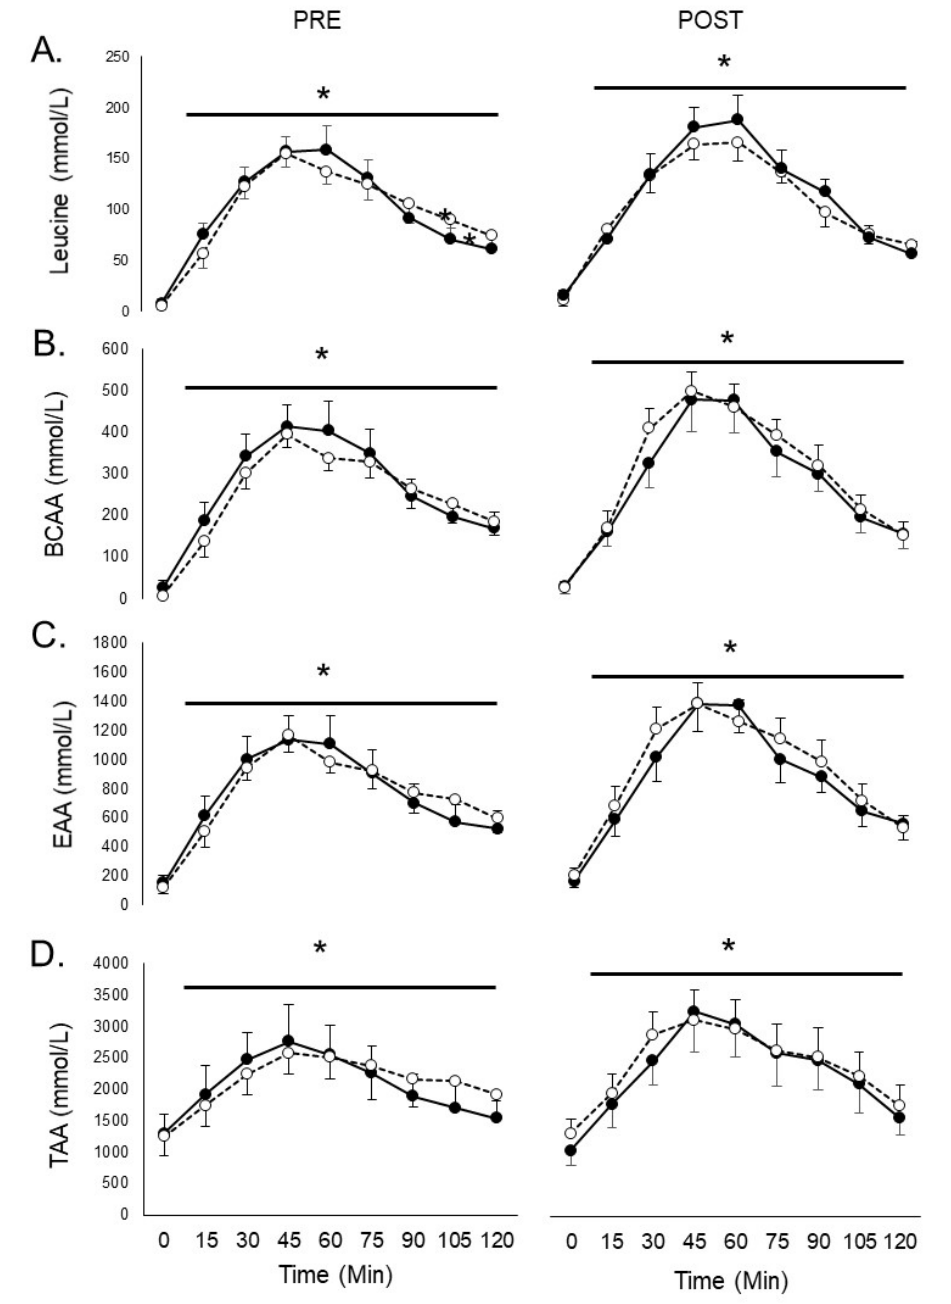
Figure 1. Plasma leucine ( A ), branched-chain amino acids (BCAAs; B ), essential amino acids (EAAs; C ), and total amino acids (TAAs; D ) from 0–120 min following consumption of 25 g of whey protein before (PRE) and after (POST) a 28-day supplement intervention. Groups: PROB: Bacillus subtilis DE111; PL: placebo. * and horizontal bar indicate a main effect of time for both groups. Values represent means ± SEM s.